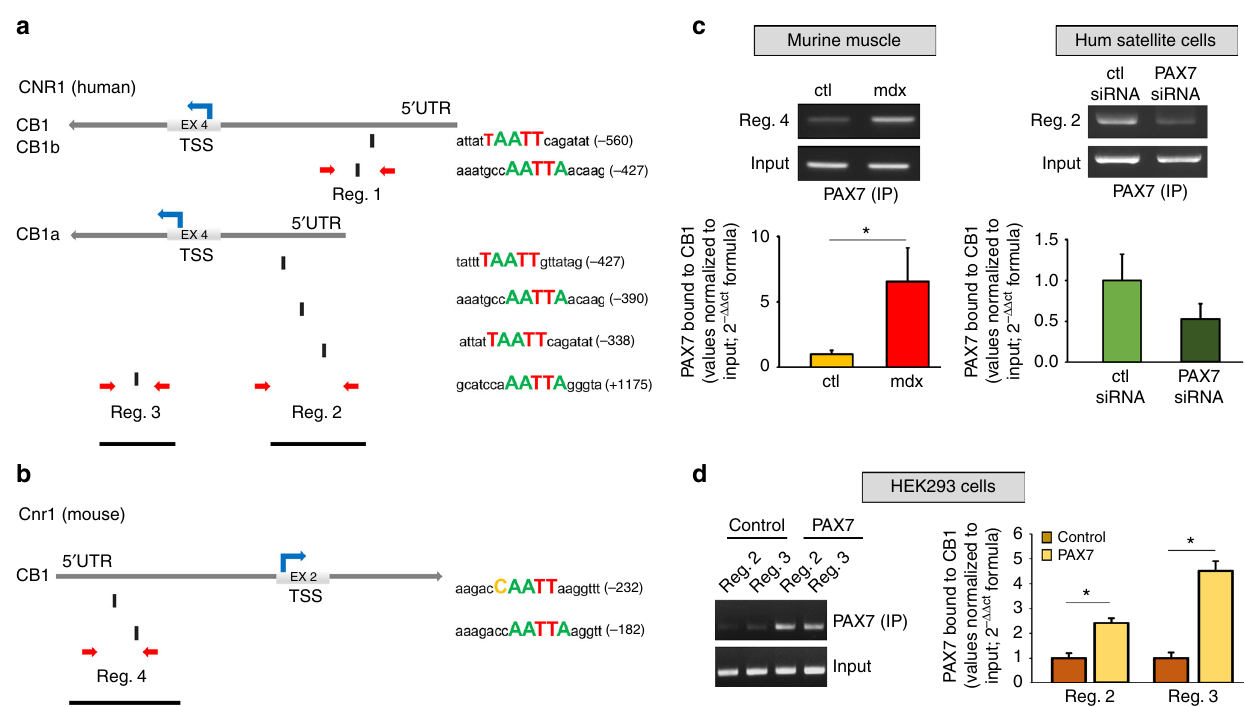
Fig. 3 Bioinformatics and ChIP analysis. Schematic representation of the human ( a ) or murine ( b ) CB1 gene. The transcriptional start site (TSS) for each gene isoform is indicated. The identi fi ed PAX7 sites are shown as small black rectangles below the schematic. Regions identi fi ed as 1 – 4, indicated by red arrows, correspond to PAX7-containing gene regions of high sequence homology in human and murine CB1 gene. c PAX7 occupancy of identi fi ed sites in the CB1 gene evaluated by chromatin immunoprecipitation (ChIP) analysis. Left: average data of the relative amount of the PAX7-immunoprecipitated DNA in the murine quadriceps muscle isolated from either wild-type or mdx mice; Right: average data of the relative amount of the PAX7-immunoprecipitated DNA in PAX7-silenced satellite cells. Data are from six separate experiments and normalized relative to the input DNA. The inset shows a representative agarose gel electrophoresis of the qPCR products obtained from PAX7-immunoprecipitated DNA for each experimental condition. d Left: representative agarose gel electrophoresis of the qPCR products obtained from PAX7-immunoprecipitated DNA for each experimental condition. Right: average data of the relative amount of the PAX7-immunoprecipitated DNA in HEK293 cells transfected with control scramble ( n = 4) human PAX7 construct ( n = 4). * P ≤ 0.05 vs. control group, determined by Student ’ s t